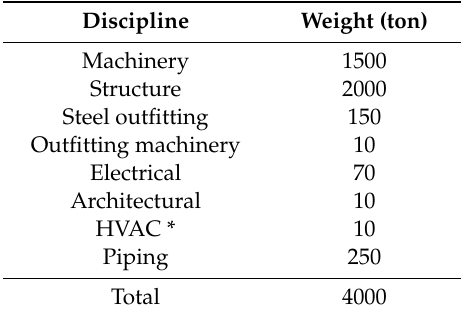
Table 1. Assumed drill floor weight in drilling operation.